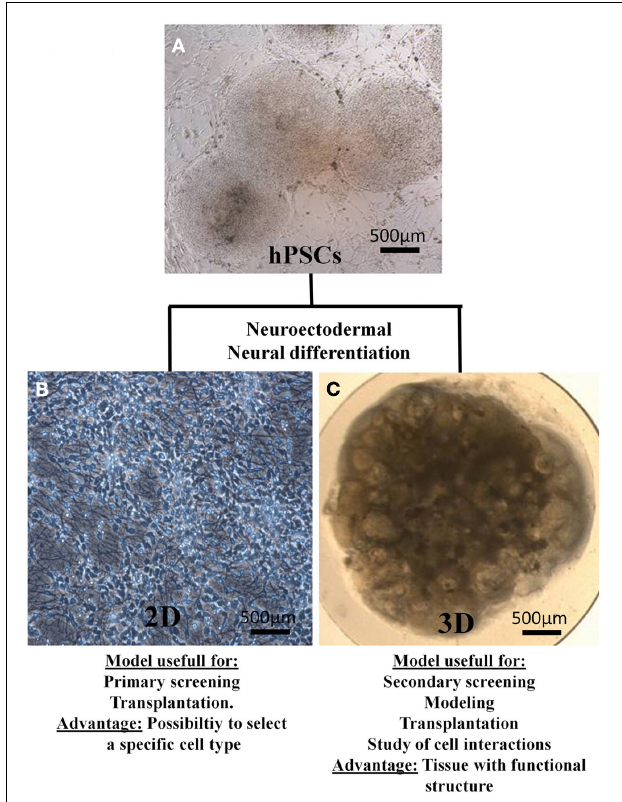
FIGURE 2 | Main biomedical applications and advantage of 2D cultures and 3D cultures. ( A ) hPSCs, H9 cell line on MEFs. ( B ) Monolayer of neurons obtained from differentiated hESC (H9 cell line). ( C ) Engineered neural tissue obtained from the differentiation of H9 on a semi-permeable